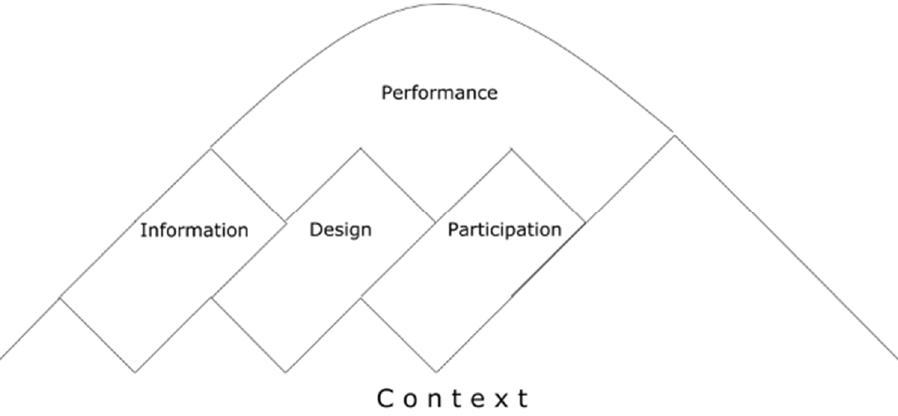
Figure 4. Conceptual representation of between-theme